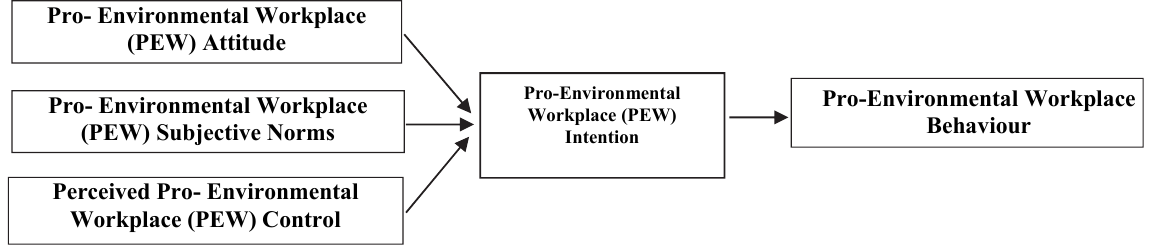
Fig. 2. PEW behavior framework based on the